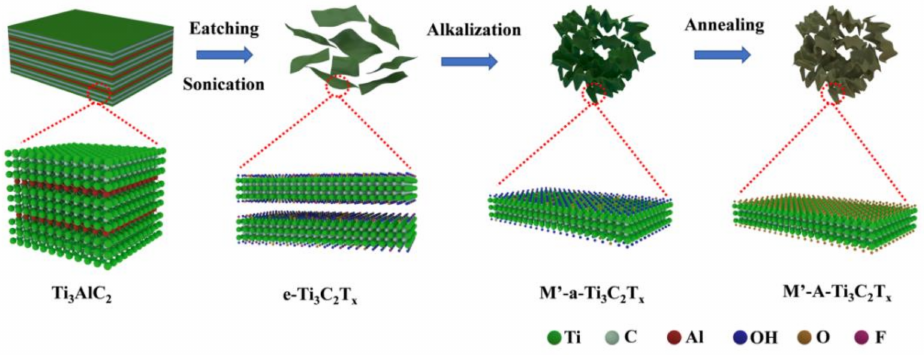
Figure 1. Preparation of 3D porous Ti 3 C 2 T x